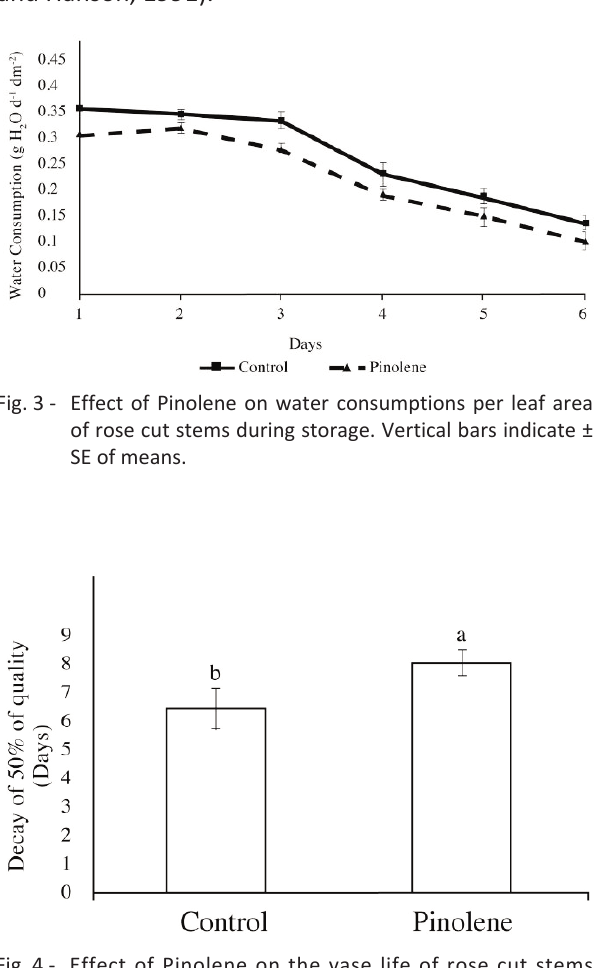
Fig. 4 - Effect of Pinolene on the vase life of rose cut stems expressed as decay of 50% of the stems quality. Different letters indicate significant differences at P≤0.05, vertical bars indicate ± SE of